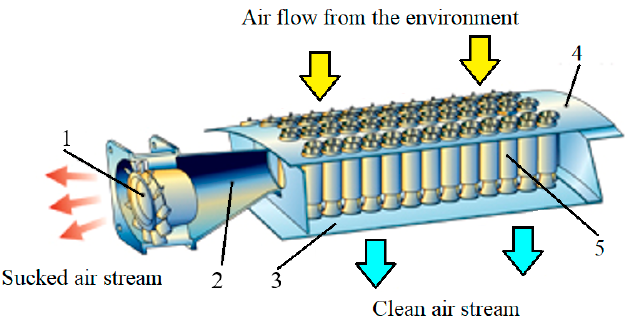
Figure 5. The system for ejective pollution suction from the air filter multi-cyclone in helicopter by means of a fan: 1—fan, 2—ejector, 3—dust collector, 4—multicyclone, 5—multicyclone housing.